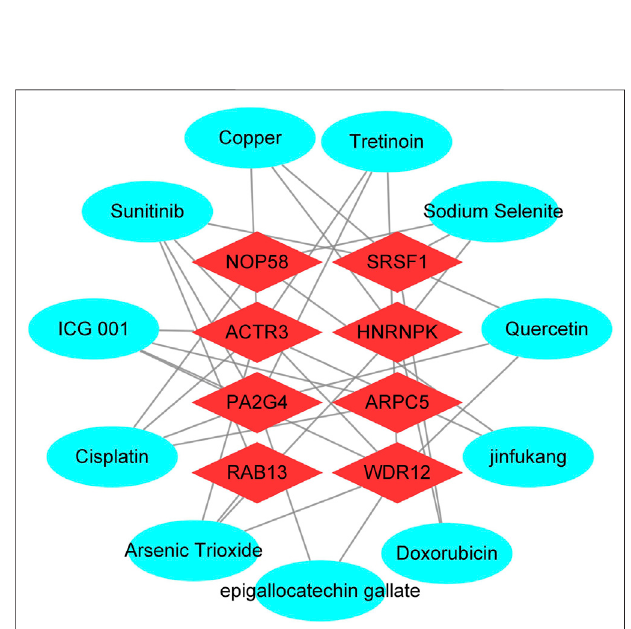
FIGURE 12 | Interactions between drugs and the identi fi ed hub genes based on CTD database and literature validation. Light blue circular node representsdrugs,reddiamondnoderepresentshubgenes,theirinteractionis represented by line, and the degree value represents the number of targets acted on by the